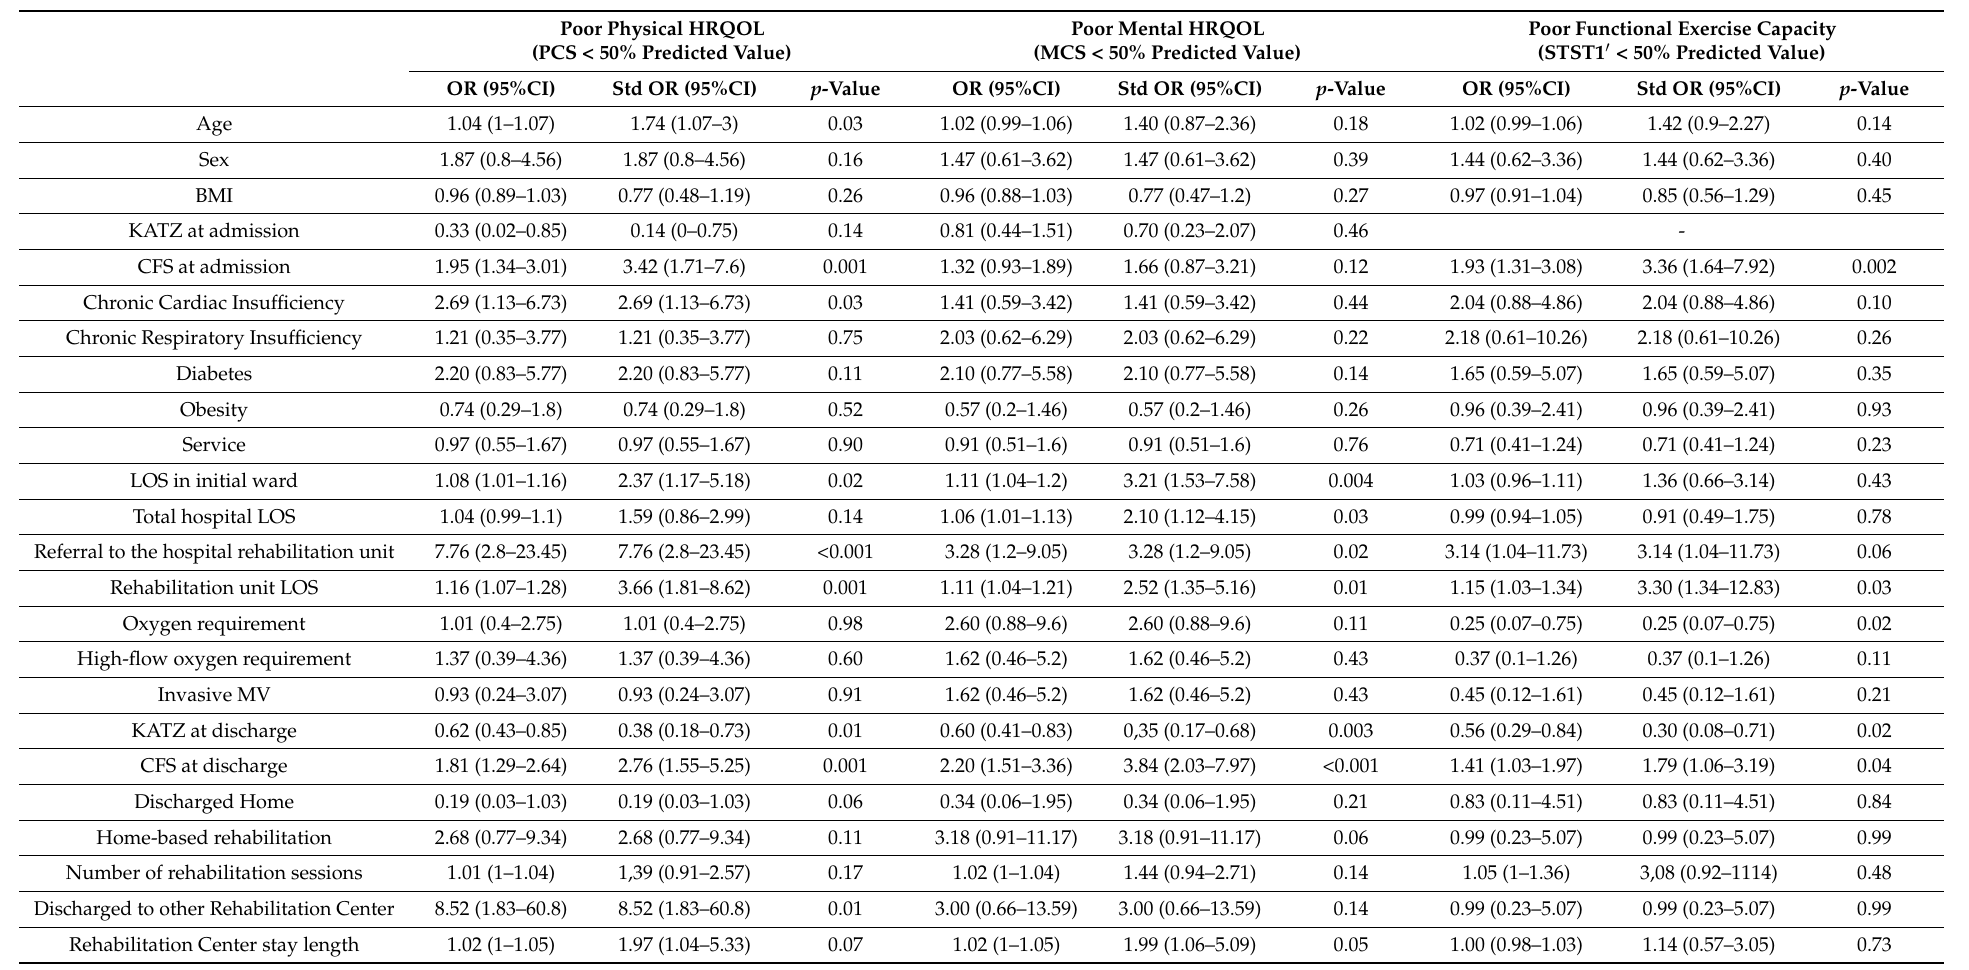
Table 3. Univariate logistic regression analyses for health-related quality of life and functional exercise capacity at the time of the remote